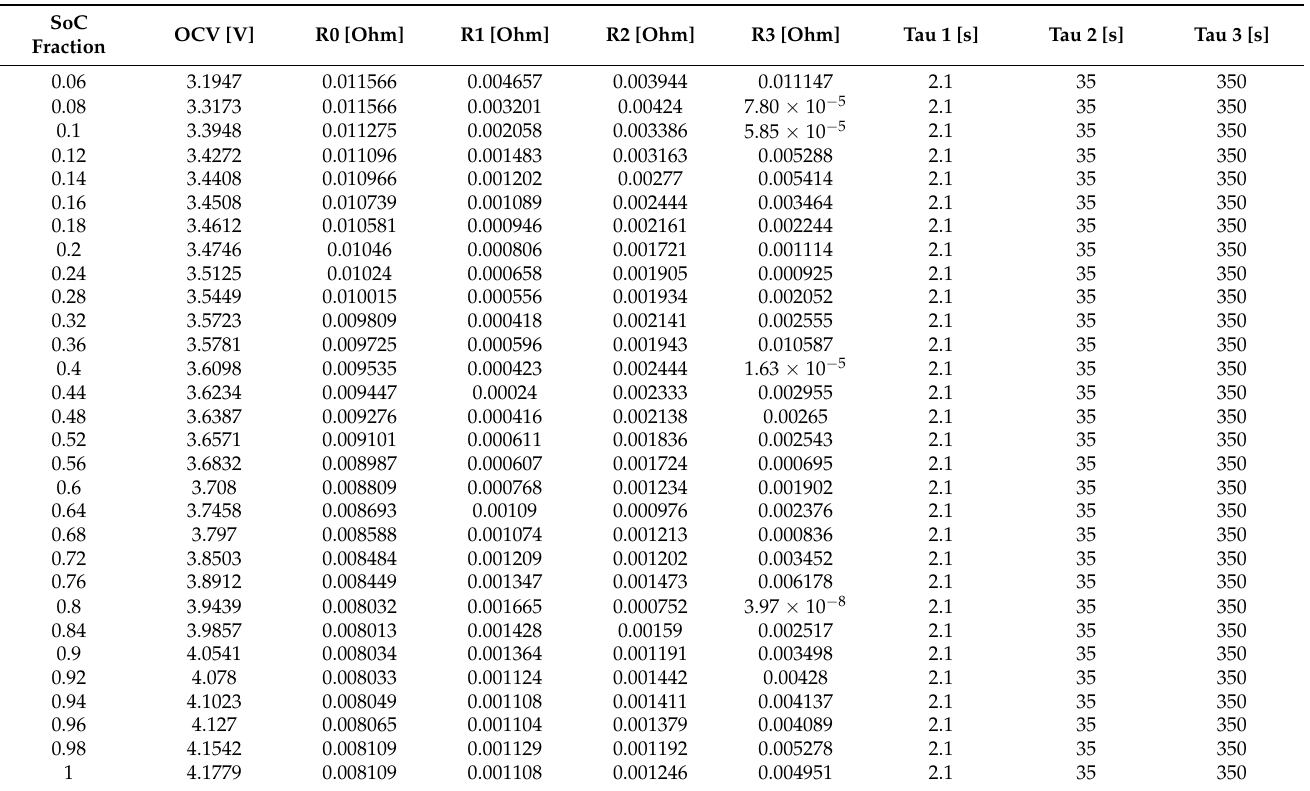
Table A2. ECM results from GITT in a climate chamber at 25 ◦ C.